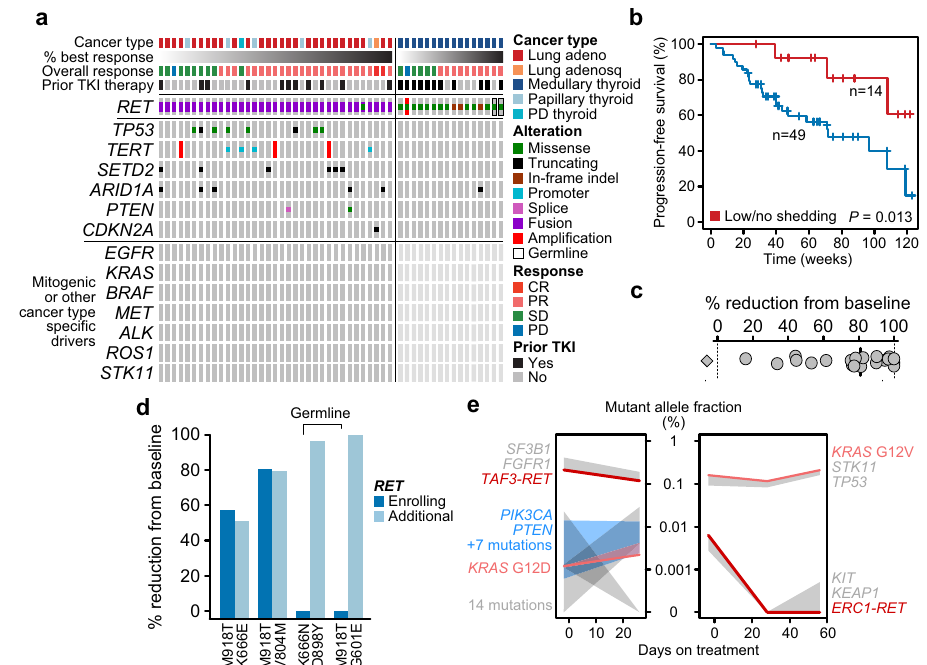
Fig. 2 Determinants of initial sensitivity to RET inhibitor therapy. a The genomic landscape of tumors acquired prior to selpercatinib treatment (dark and light gray, evaluated and no alterations observed). b Clinical bene fi t from selpercatinib treatment in patients with or without (no or minimal) evidence of tumor shedding in cfDNA (blue and red, respectively). P as indicated, likelihood ratio test. c The percent reduction in the mutant allele fraction of the enrolling RET alteration from baseline to the fi rst time point after the start of treatment. Black line is the median (82.5%) reduction in all evaluable patients, the diamond is a single patient with an increased plasma frequency of RET after treatment initiation (patient had partial response lasting nearly a year, but second time point collected three weeks after progression). d In plasma, the percent reduction in the frequency of the RET enrolling alteration alongside the additional RET lesion present prior to selpercatinib therapy due to prior MKI therapy. e Two patients with primary resistance to selpercatinib in whom plasma cfDNA pro fi ling at baseline identi fi ed KRAS mutations not detected by tumor tissue sequencing and presumed in distinct cancer populations (shading signi fi es the minimum and maximum allele frequency detected in each independent subclone) from the sensitizing RET fusion, which decreases upon treatment